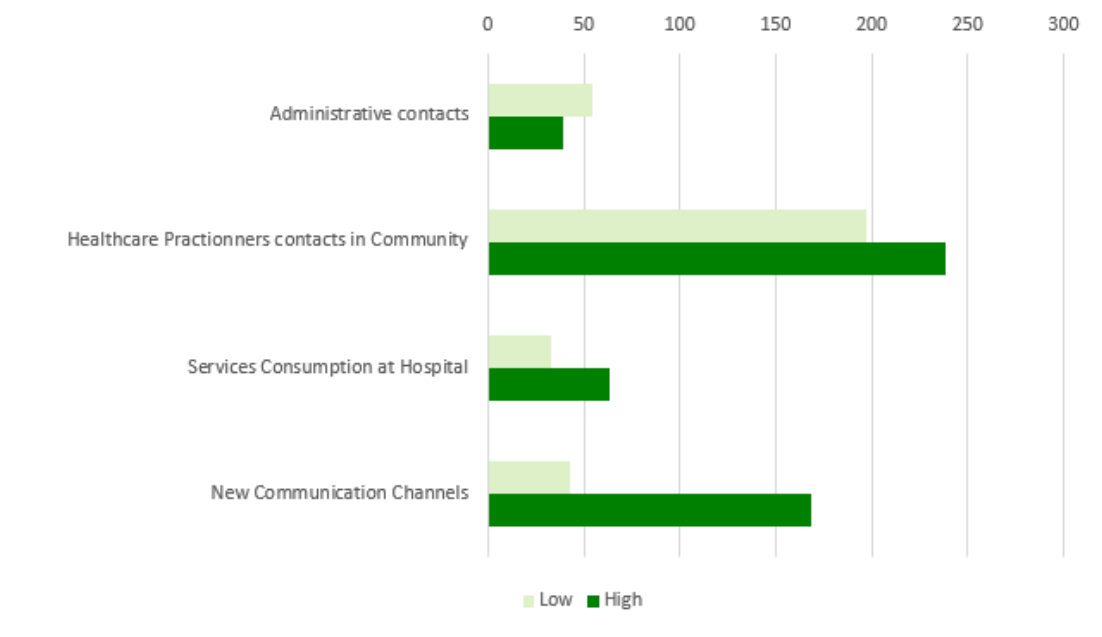
Figure 3. Low-to-moderate versus moderate-to-high health care services consumption of patients with diabetes in 2016.